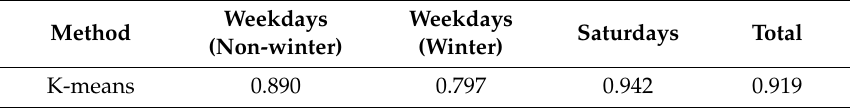
Table 5. External evaluation results of K-means.